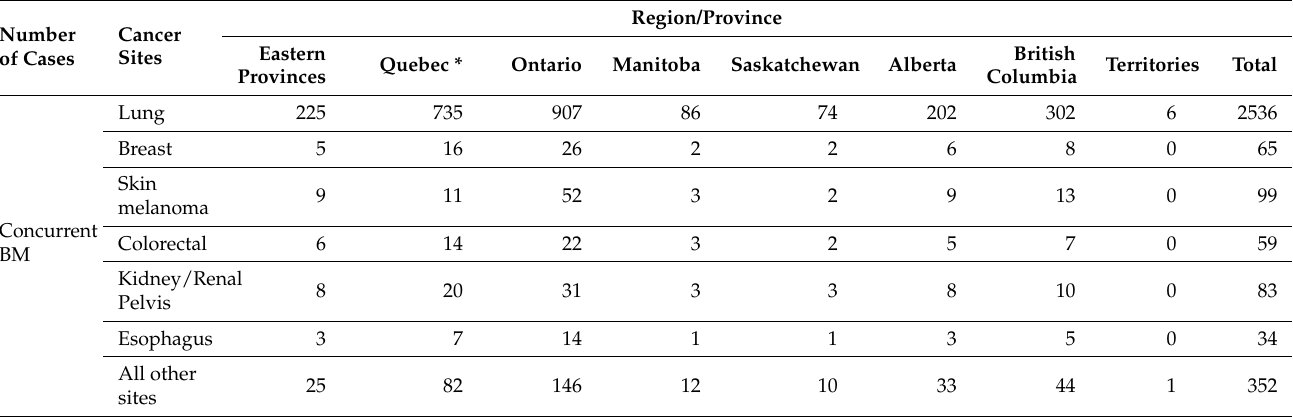
Table A3. Average annual estimates of concurrent brain metastases by provinces/territories among cancer patients diagnosed in Canada (2010–2017) by selected primary cancer